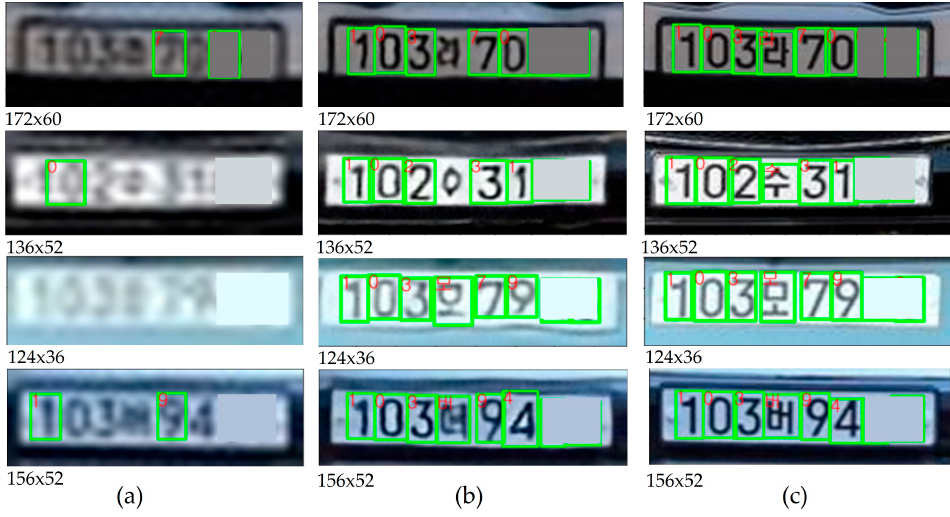
Figure 13. Examples of character recognition results. Recognition results on ( a ) bicubic results (4 × ), ( b ) proposed SR results (4 × ), and ( c ) HR images. Two characters were masked due to privacy poli- cies.